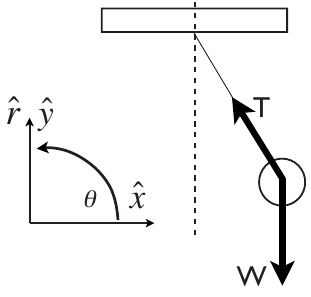
FIG. 3. Two coordinate systems from Wes. At first, he draws the x and y coordinates. In response to Derek’s polar suggestion, he replaces y with r , labels the angle between r and x as (cid:1) , and erases x .